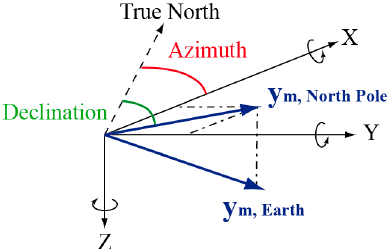
Figure 1. Estimation of the azimuth angle using the Earth’s magnetic field measurement y m and the declination angle between the True North and the horizontal component.